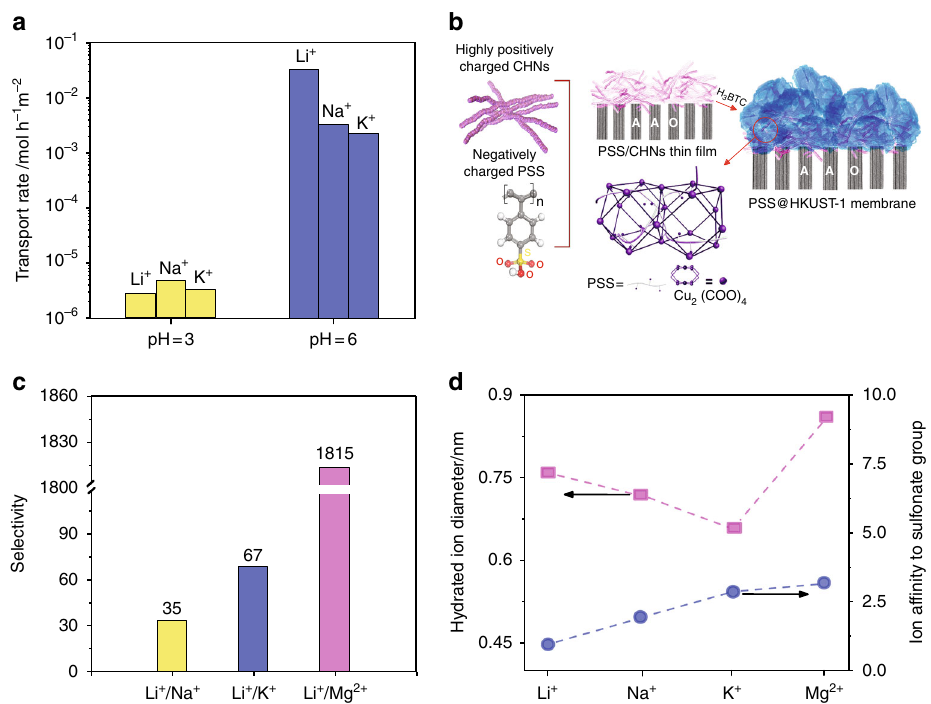
Fig. 5 Effect of nanochannels surface charge on Li-ion selectivity and performance. a Ionic transport rates of monovalent cations as a function of pH in 0.6 nm diameter PET membrane. The bar chart presents that reducing the pH (protonation) can mitigate the negative charge density of carboxylic acid groups in the nanochannels resulting in a signi fi cant drop in the ion transportation rate and thus Li + selectivity, Reprinted with permission from ref. 42 Copyright 2019 John Wiley and Sons. b The preparation procedures of PSS-threaded HKUST-1 membranes via a solid con fi nement conversion process from a thin fi lm of copper hydroxide nanostrands (CHNs) that are coated with negatively charged polystyrene sulfonate (PSS) on AAO. c The binary ion selectivities of PSS-threaded HKUST-1 (0.5 M LiCl and 0.5 M KCl and MgCl 2 electrolytes, dashed lines are guids to the eye). The high Li + af fi nity of sulfonate groups (about four sulfonate groups/nm) to Na + and K + was used to develop a high-performance Li-ion selective membrane. d Hydration diameters and ion af fi nities to sulfonated group related to that of Li + , Na + , K + , and Mg 2 + . Reproduced with permission from ref. 46 Copyright 2019 John Wiley and